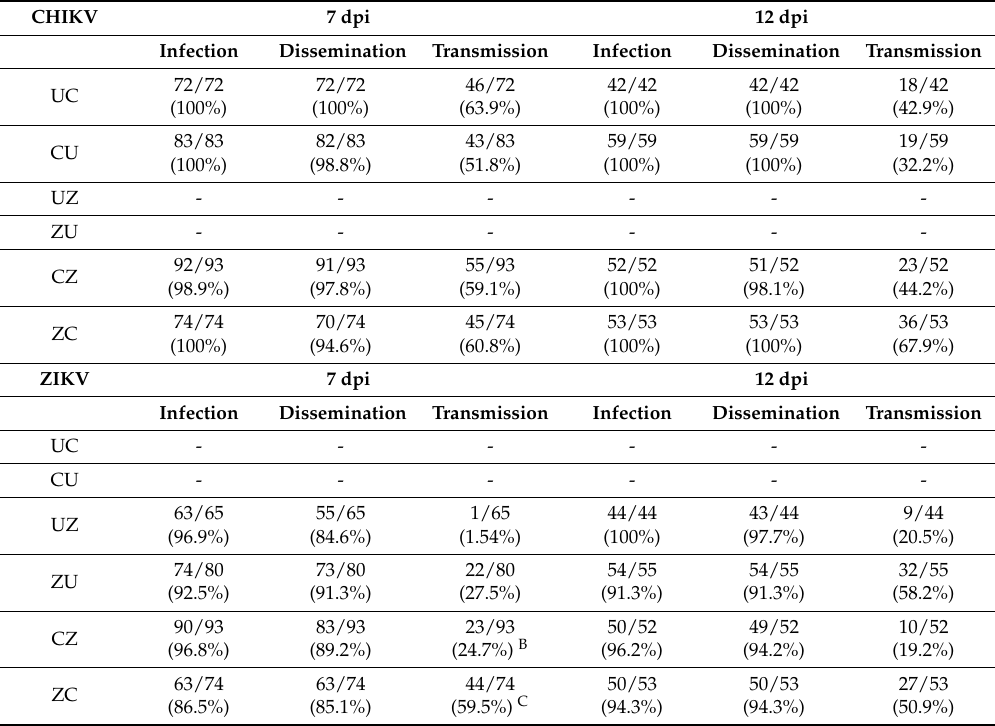
A Combined data from three replicate experiments is shown. Statistical analysis accounted for individual replicates (see Methods). B ZIKV transmission rates were significantly increased ( p = 0.0424) in group CZ compared to